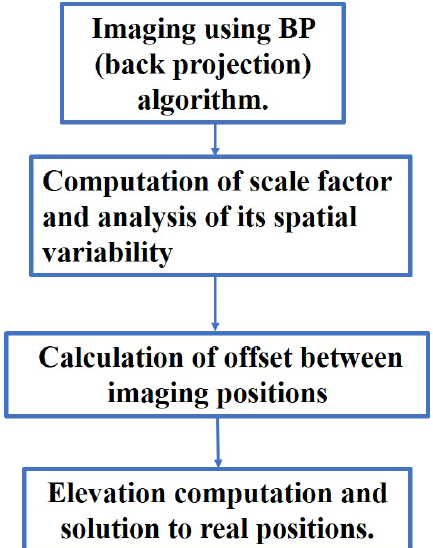
Figure 3. Flowchart of the digital elevation model(DEM) generation